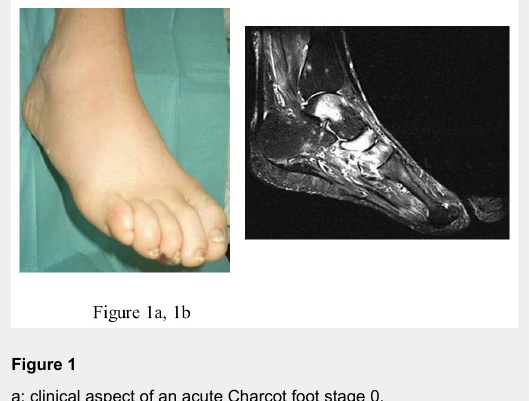
a: clinical aspect of an acute Charcot foot stage 0. b: MRI (T2w, fat suppressed) showing marrow oedema in the talus, and the navicular and cuneiform bones plus adjacent soft tissue oedema (bright appearance)